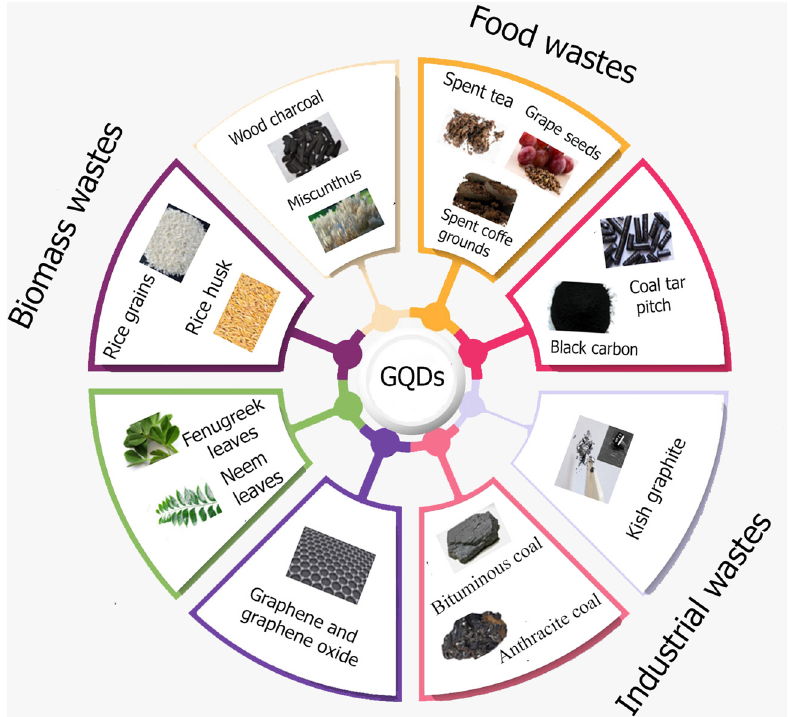
Figure 14: Wastes used as precursors for synthesizing